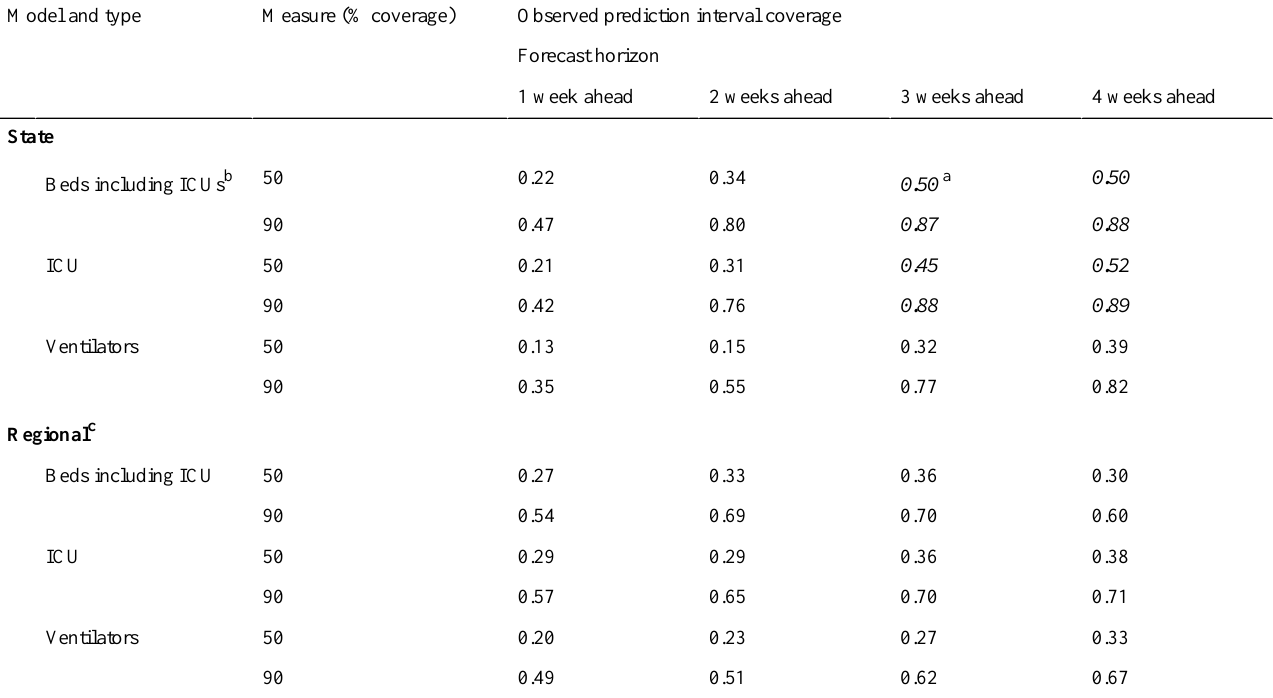
Table 3. Observed prediction interval coverage for COVID-19 health care use needs in New Mexico reported from September 1 to December 9,